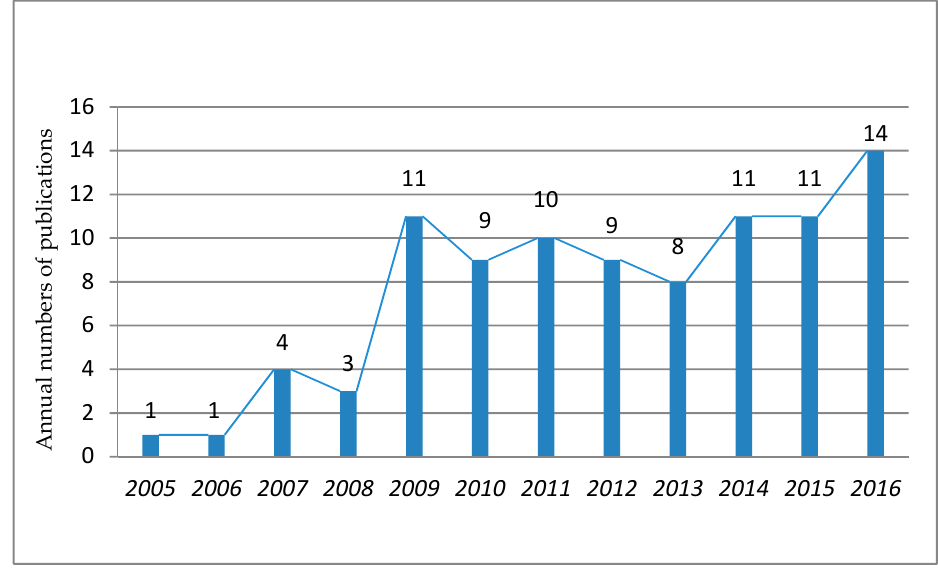
Figure 2. Year profile of publications.